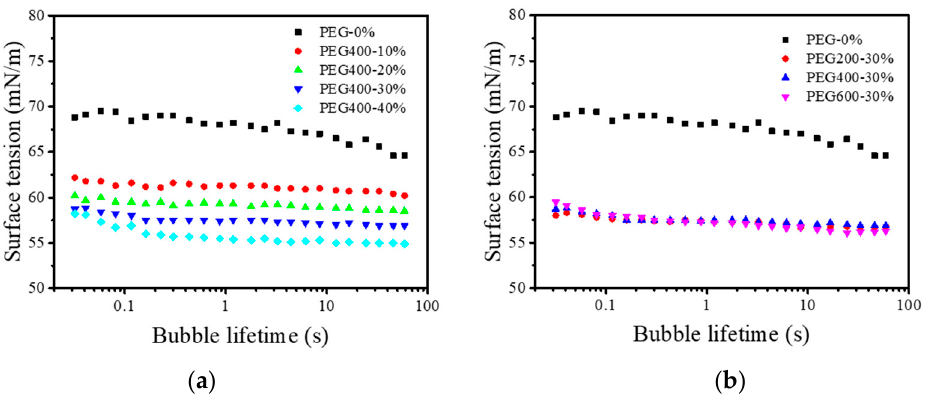
Figure 5. The surface tension of Red 21 8 dye inks: ( a ) At different PEG400 concentrations; ( b ) At different PEG molecular weights. The Red 218 concentration was 7%, and the temperature was 25 °C.